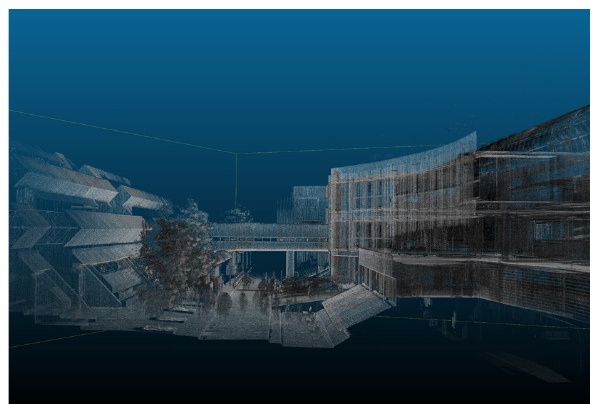
Figure 25. Outdoor TIMMS point